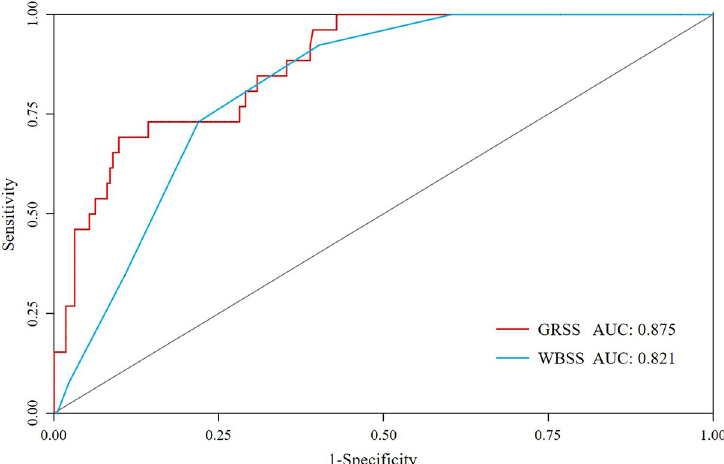
Fig 1. Receiver-operating characteristic curves of the Global Respiratory Severity Score and the Wang bronchiolitis severity score. The AUCs for the GRSS and the WBSS are 0.875 and 0.821, respectively, corresponding to cut-off values of � 4.52 and � 7, respectively.